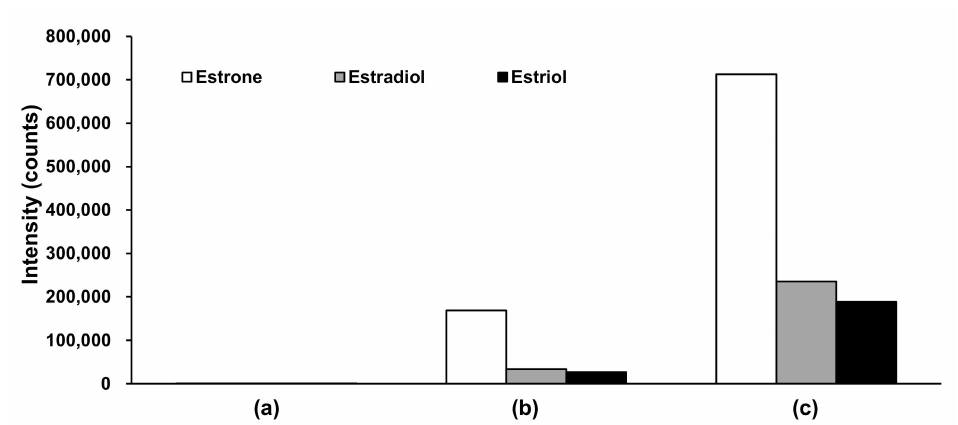
Figure 2. Comparison of peak intensities in negative ion detection mode for various mobile phases.